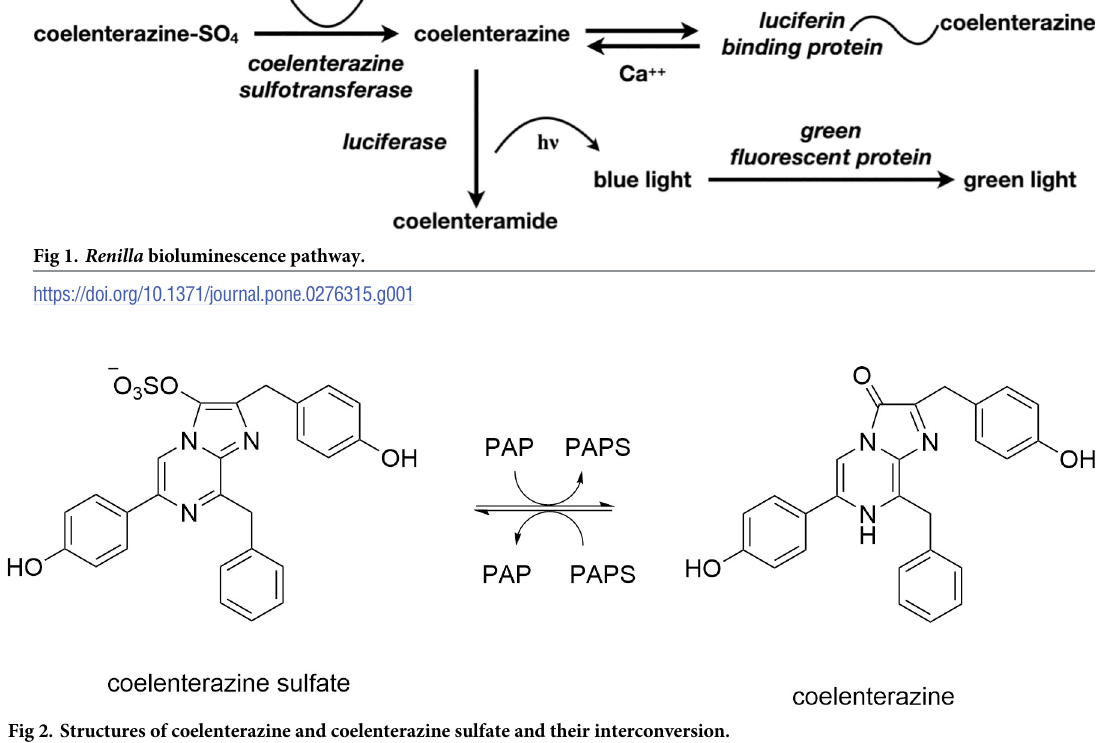
Fig 2. Structures of coelenterazine and coelenterazine sulfate and their